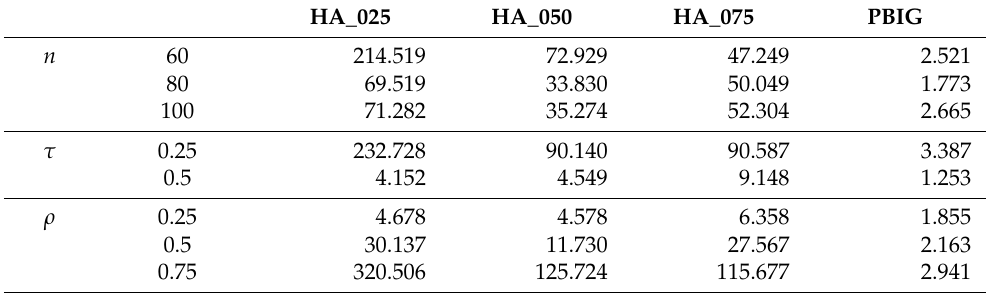
Table 7. The RPD values of the four